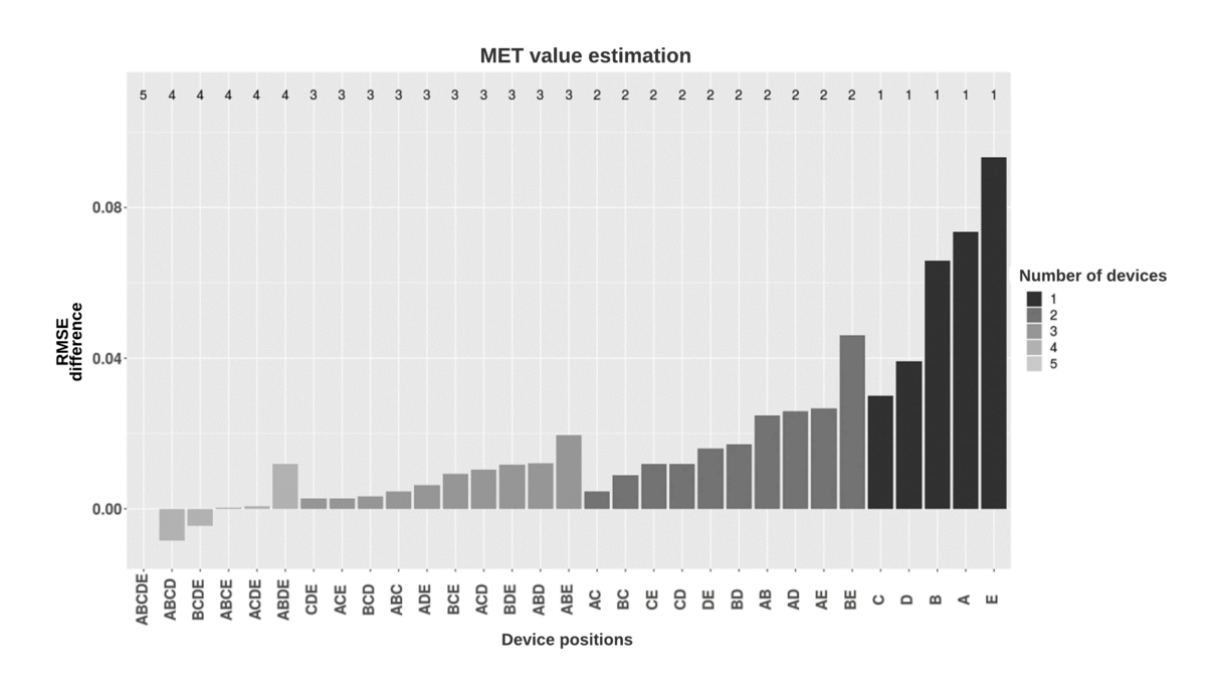
Figure 7. Root mean square error (RMSE) score performance of met value estimation models based on the device placement combinations. Models were grouped by the number of devices used and, in each group, were sorted in increasing RMSE (rounded). Y-axis shows the difference between the RMSE values of the different combinations and the five-placement combination. A: ankle; B: upper arm; C: hip; D: thigh; E: wrist; MET: metabolic equivalent; RMSE: root mean square error.